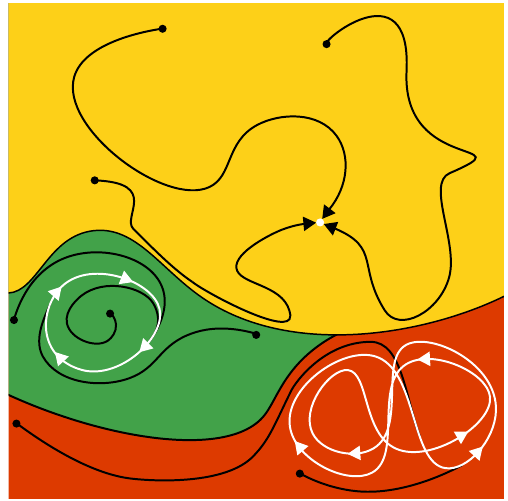
Figure 11: Generalised basins for dynamical systems. In a generic dynamical system, basin of attractions can be associated not only to fixed points, but also limit cycles, or any kind of stable attractor of the dynamics. Black arrows represent example trajectories, that fall into steady-state structures (white). These structures can be fixed points (yellow basin), simple limit cycles (green basins) or any complicated high-dimensional at- tractor (red